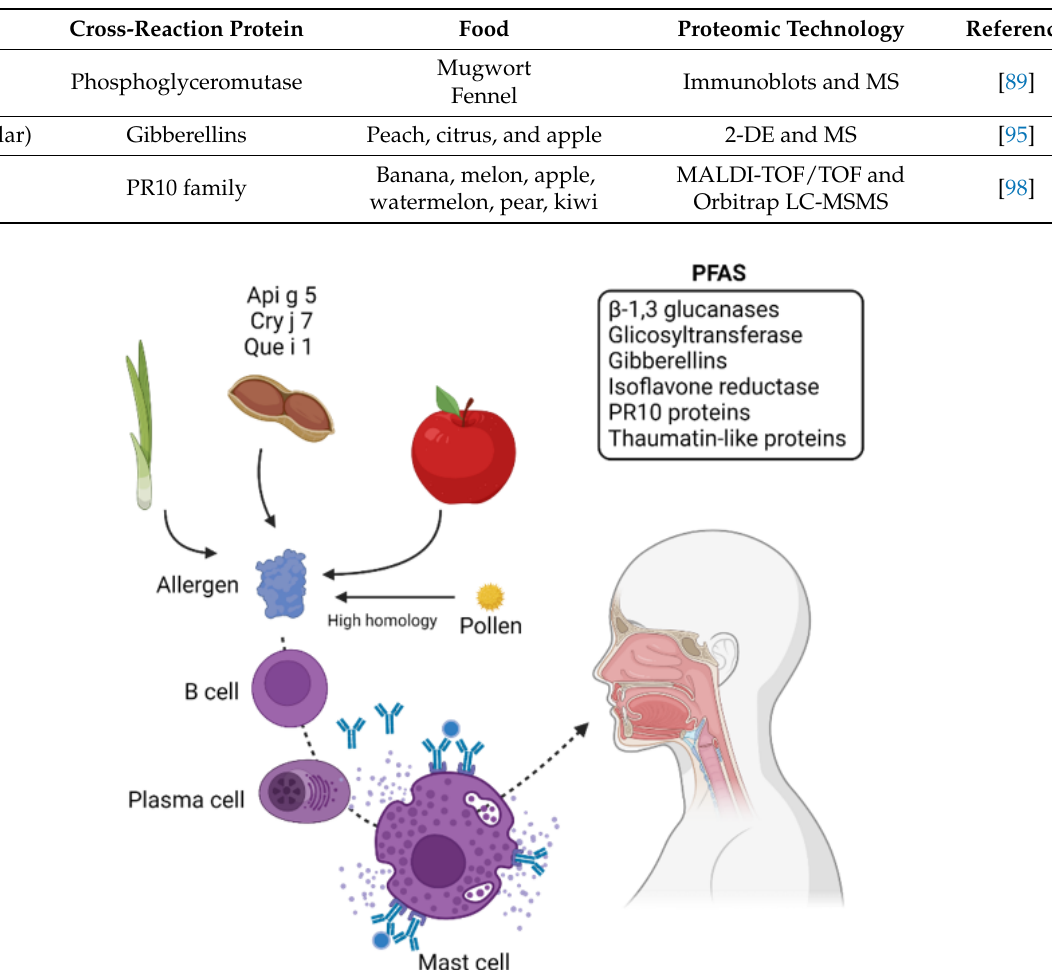
Table 3. Principal allergens and cross-reactive proteins are described with proteomics in PFAS.